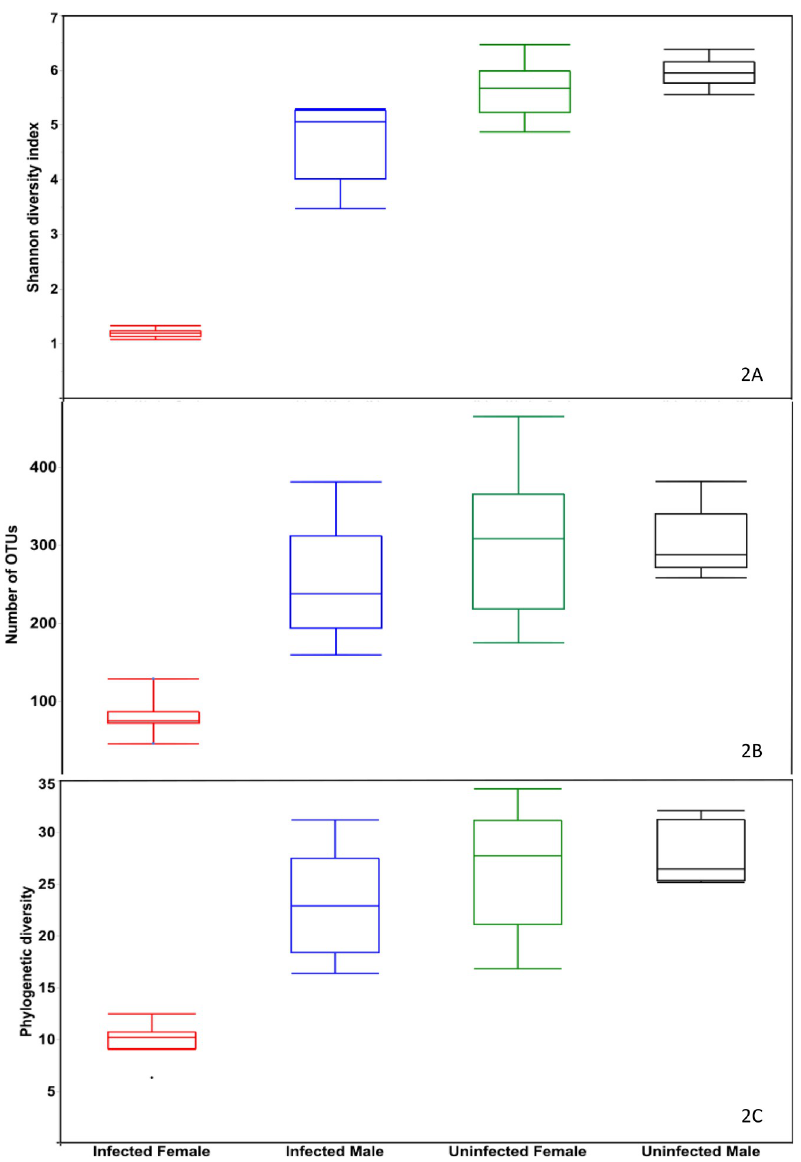
Fig 2. Alpha diversity among adult mites infected and uninfected with Orientia tsutsugamushi . Boxplots show the Shannon diversity index (A); the number of observed OTUs (B) and phylogenetic diversity (PD) of the tree (C). File for groups; see S4 File for individual pooled samples). For adult male mites from the infected colony, we found 6 bacterial taxa with average relative abundances that were greater than 5%; specifically the family Xanthomonadaceae (genus Luteimonas 18.3%), Xanthomona- daceae (7.4%), Rickettsiaceae (genus Orientia , 7.1%), Chitinophagaceae (6.1%), Mycobacteria- ceae (genus Mycobacterium , 5.7%), and Pseudomonadaceae (genus Pseudomonas , 5.4%). For the infected deutonymphs, we found only 3 bacterial taxa with a relative abundance greater than 5%: genus Orientia (36.94%), family Amoebophilaceae (31.4%) and genus Stenotropho- monas (6.8%). For the infected larvae, we found only 3 bacterial taxa with a relative abundance greater than 5%: genus Orientia (16.8%), Ralstonia (8.8%) and Propionibacterium (7%).